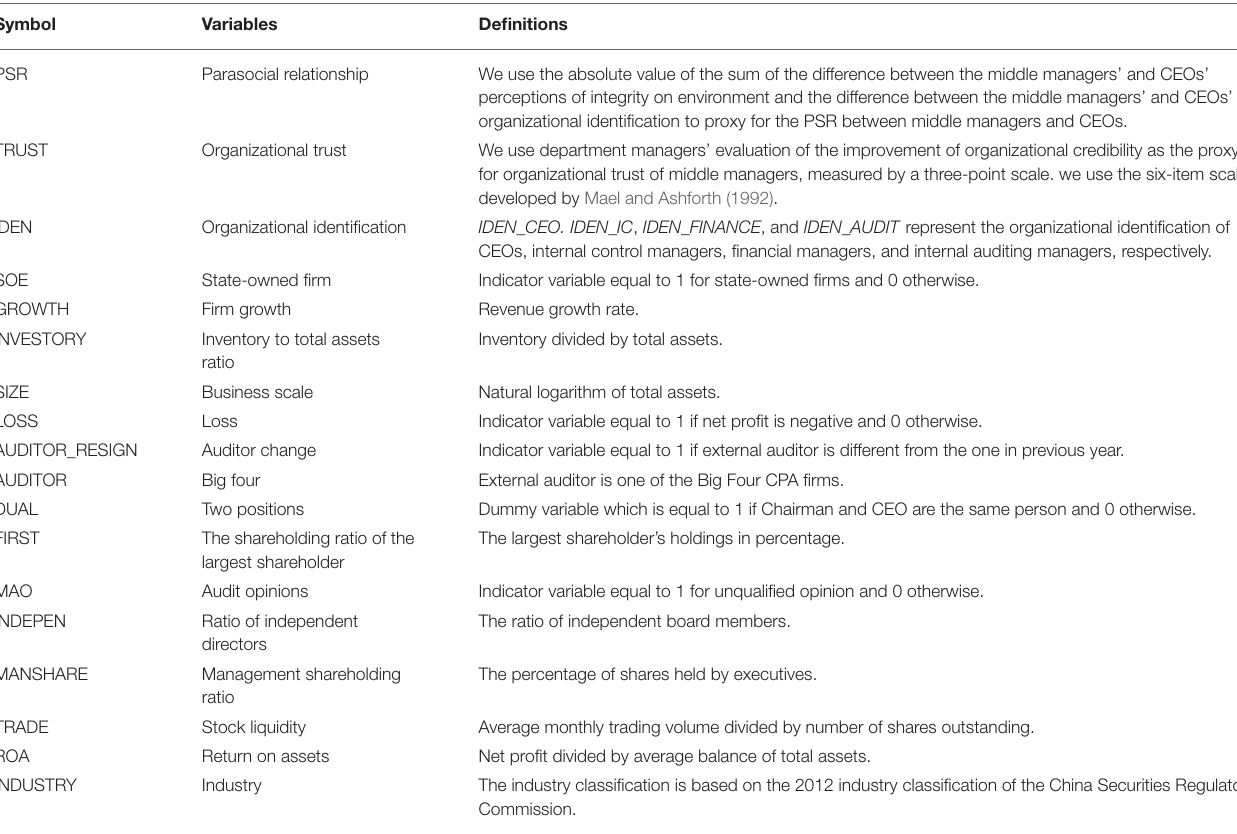
TABLE 1 | Definitions of